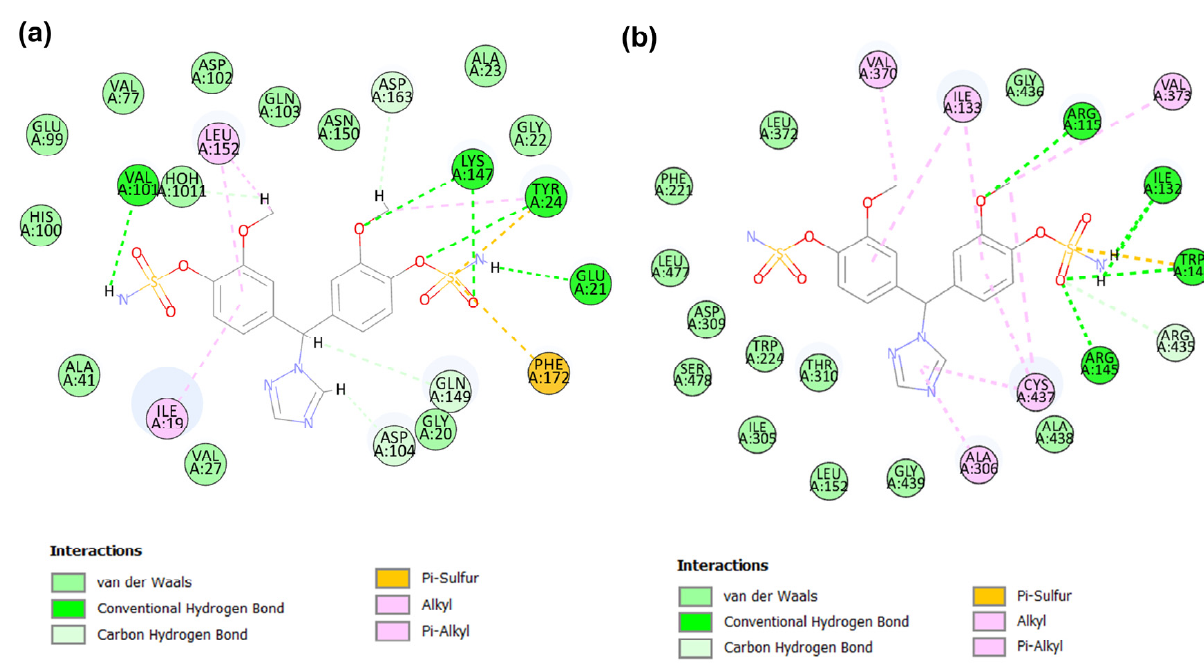
Figure 8. 2D plot of potential candidate 2 in CDK6 ( a ) and aromatase ( b ) at the binding site. Regarding molecular docking of candidate 2 at the active site of aromatase, it exhibited a CDOCKER energy of − 25.29 kcal/mol and CDOCKER interaction energy of − 52.21 kcal/mol (Table 3). The elucidation of the potential binding modes of candidate 2 in the aromatase active domain demonstrated several interactions with amino acid residues such as Arg115, Ile133, Ile132, Trp141, Arg145, Ala306, Asp309, Val370, Val373, and